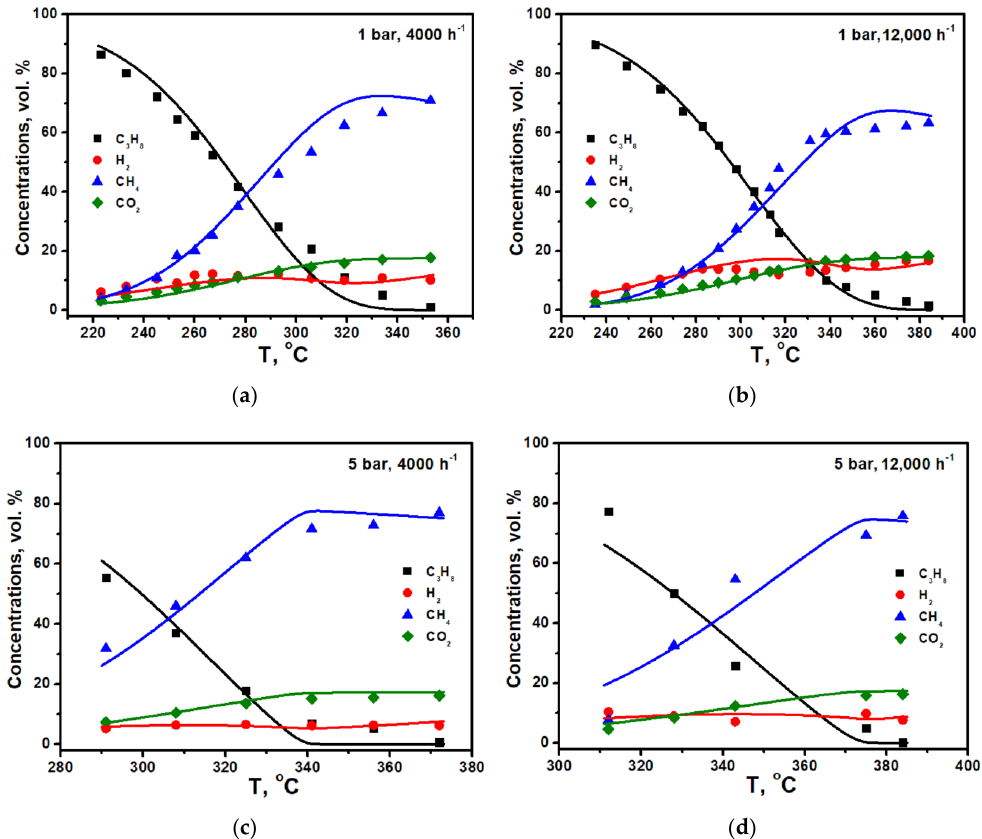
Figure 3. Temperature dependences of the outlet concentrations of propane, methane, CO 2 and hydrogen in propane pre-reforming. Points are the experiment, and lines are the modeling. Experimental conditions: 25 vol.% C 3 H 8 , 75% H 2 O and pressure 1 bar. The solution of the inverse problem is according to the Langmuir–Hinshelwood (LH) model. Concentrations of the gas components on and 4000 h − 1 , Figure 3b—1 bar and 12,000 h − 1 , Figure 3c—5 bar and 4000 h − 1 , Figure 3d—5 bar and 12,000 h − 1